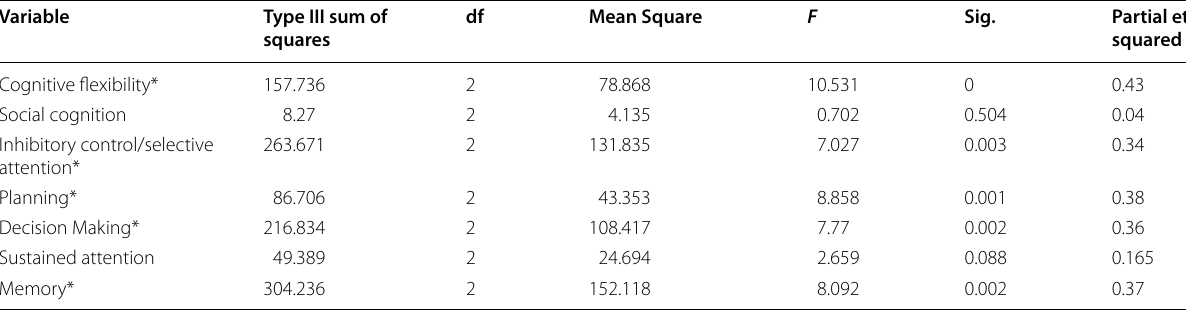
*The mean difference is significant at p < 0.05